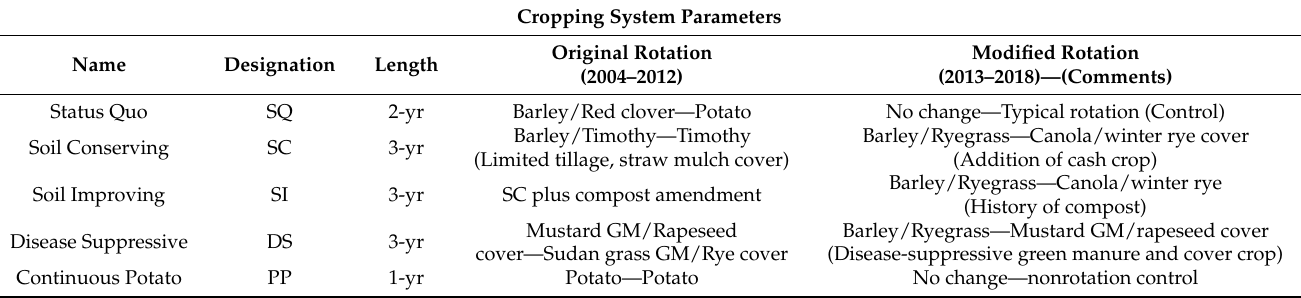
Table 1. Names, descriptions, and features of the cropping systems used to address specific manage- ment goals in these studies. GM = green manure